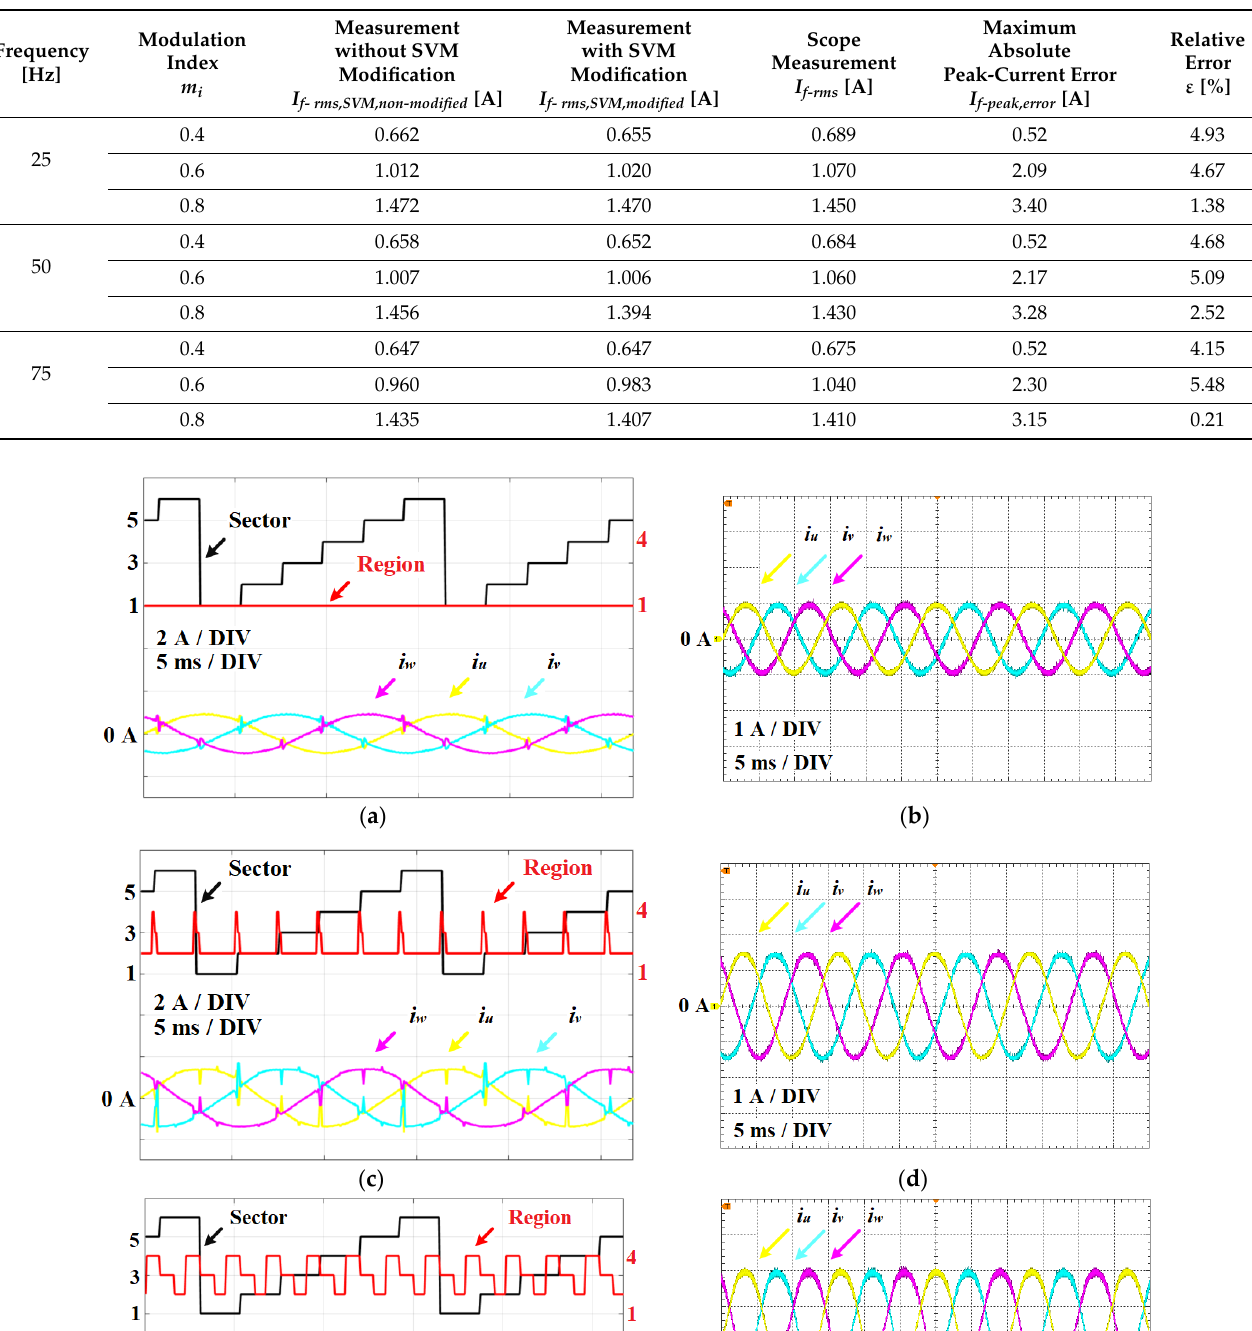
Table 11. Performance index for measurement results.